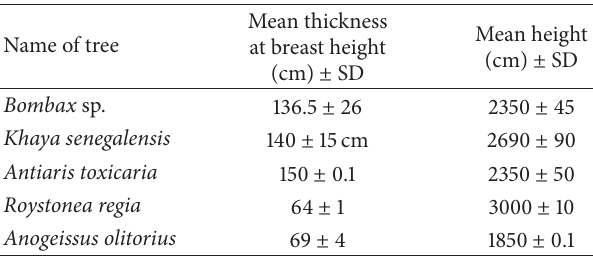
Table 3: Tree species used by roosting Hooded Vultures in Accra [15, 21]. Name of tree Bombax